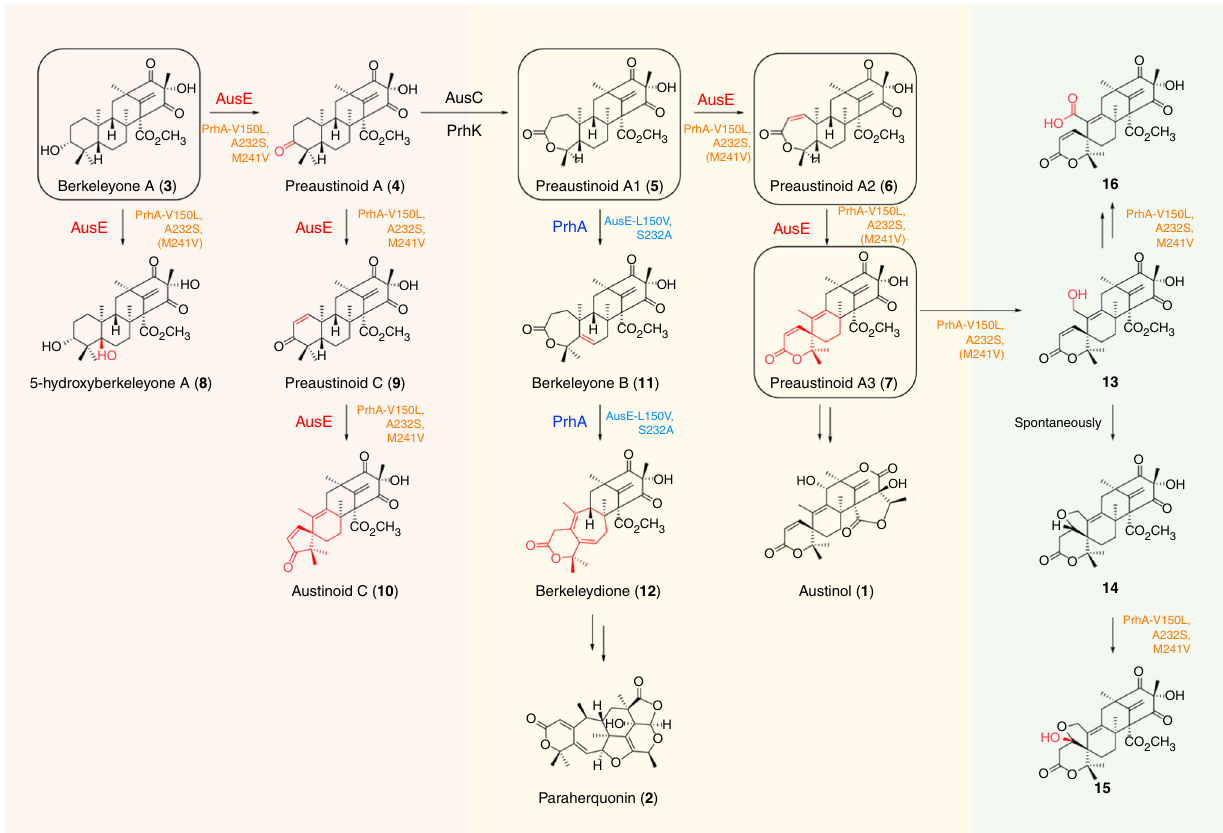
Fig. 4 Reactions catalyzed by multifunctional AusE and PrhA oxygenases. Left block (red) summarizes the reactions catalyzed by AusE or PrhA-V150L/ A232S/(M241V) from berkeleyone A ( 3 ). Middle block (yellow) summarizes the reactions catalyzed by AusE, PrhA, AusE-L150V/S232A, and PrhA- V150L/A232S/(M241V) from preaustinoid A1 ( 5 ). Right block (green) summarizes the reactions catalyzed by PrhA-V150L/A232S/(M241V) from preaustinoid A3 ( 7 ) to generate unnatural compounds ( 13 – 16 ). Substrates used to obtain complex structures are